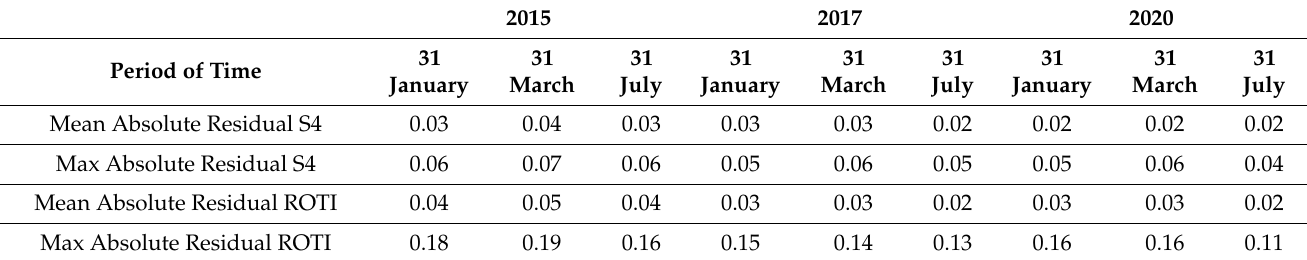
Table 5. The residual values of observed minus predicted S4 and ROTI during 24 h on 31 January, 31 March, and 31 July in